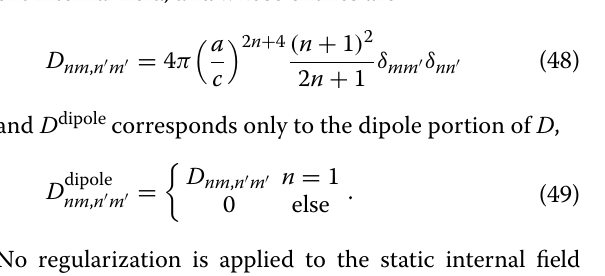
No regularization is applied to the static internal field coefficients g static . The alignment parameter splines are regularized by minimizing an approximation to their curvature (the sec- ond time derivative), integrated over the time period of interest,